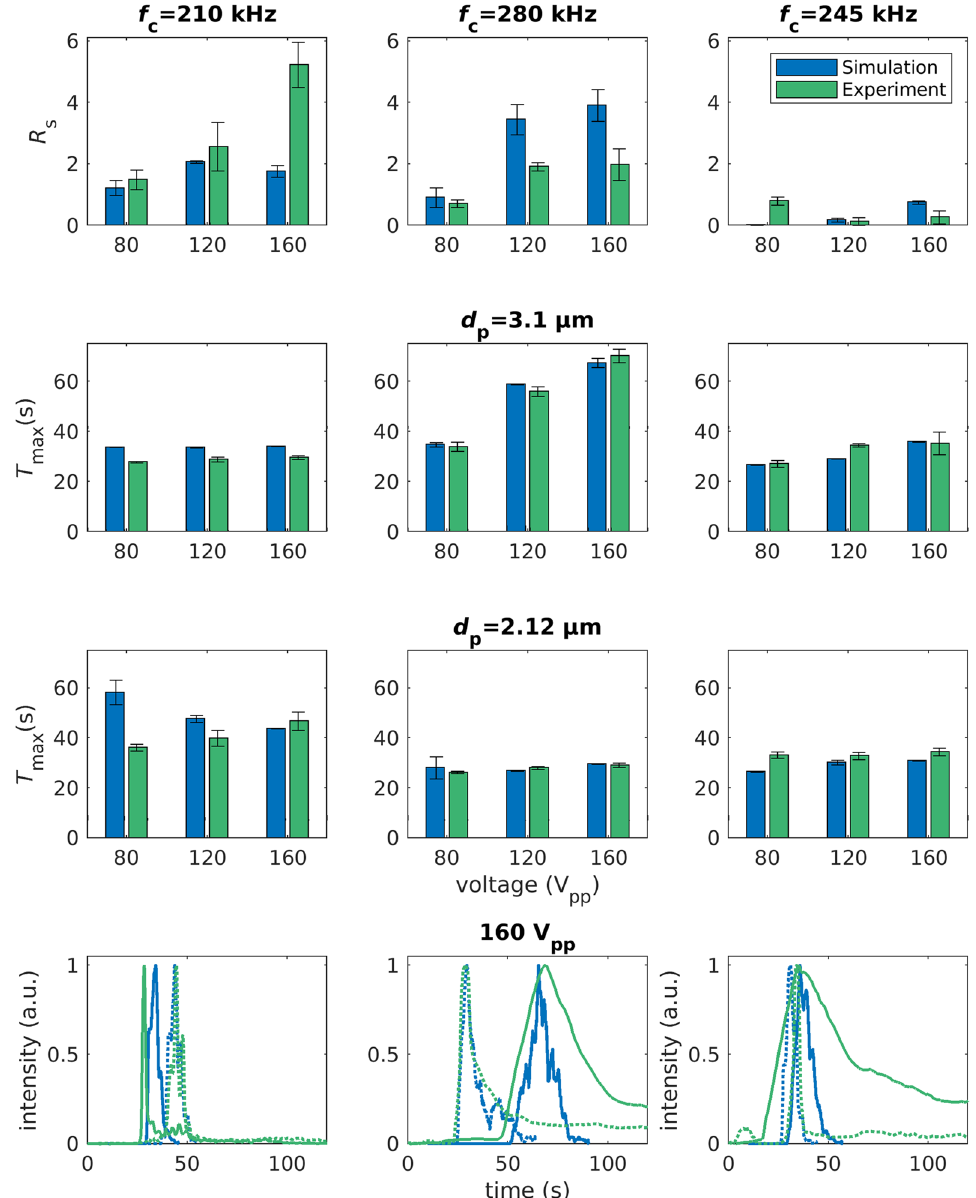
Figure 3. Top: Resolution and standard deviation of experimental and simulated frequency-modulated chromatography experiments at 80, 120 and 160 V pp for three different modulation spectra. Surface conductance of the 2.12 µ m and 3.1 µ m particles are simulated with 0.775 nS and 1 nS, respectively. Middle two rows: Corresponding maxima of the residence time distributions and standard deviations for 3.1 µ m and 2.12 µ m particles. Bottom: Residence time distributions of experiment (green) and simulation (blue) for 3.1 µ m (solid line) and 2.12 µ m (dashed line) particles at different centre frequencies (210, 280 & 245 kHz) and 160V pp . Simulations and experiments were repeated 5 times to check for statistical